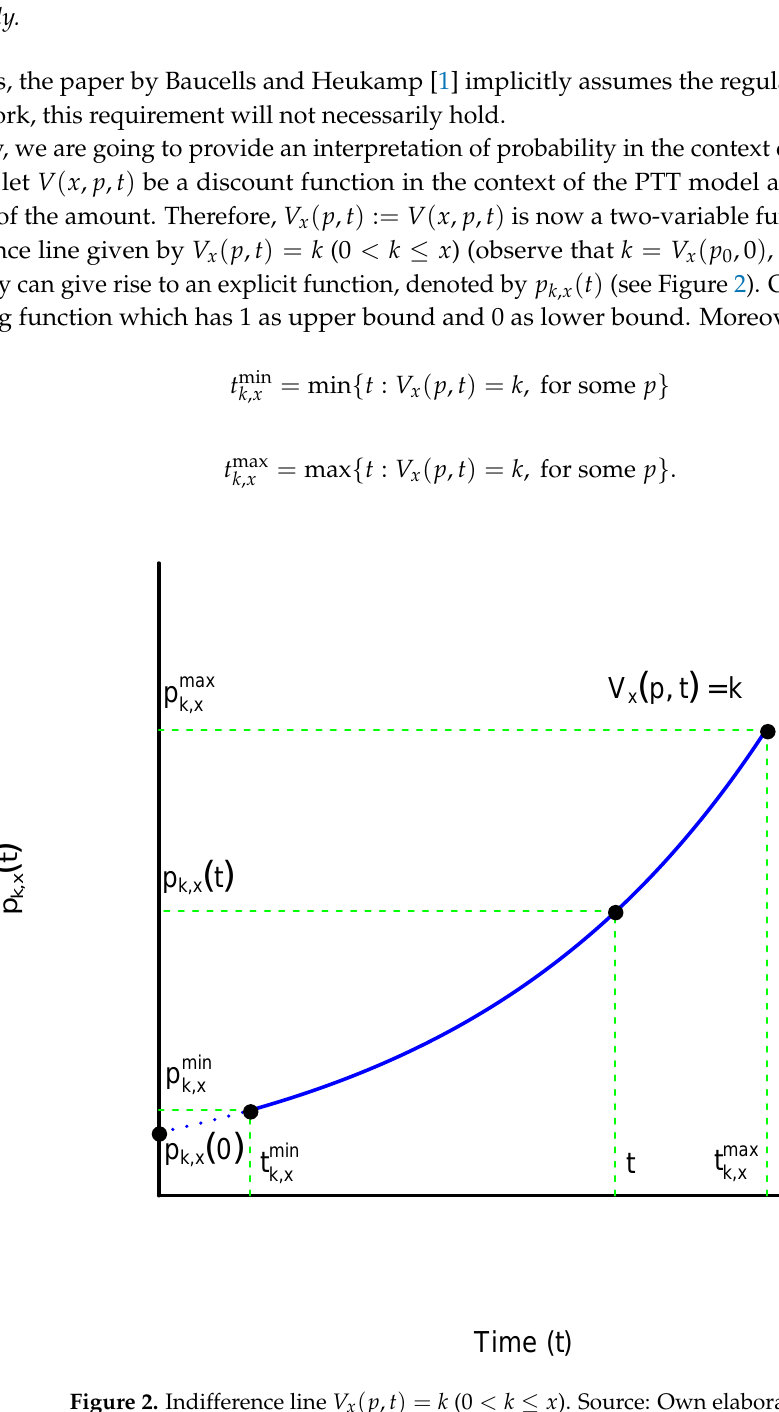
Figure 2. Indifference line V x ( p , t ) = k (0 < k ≤ x ). Source: Own